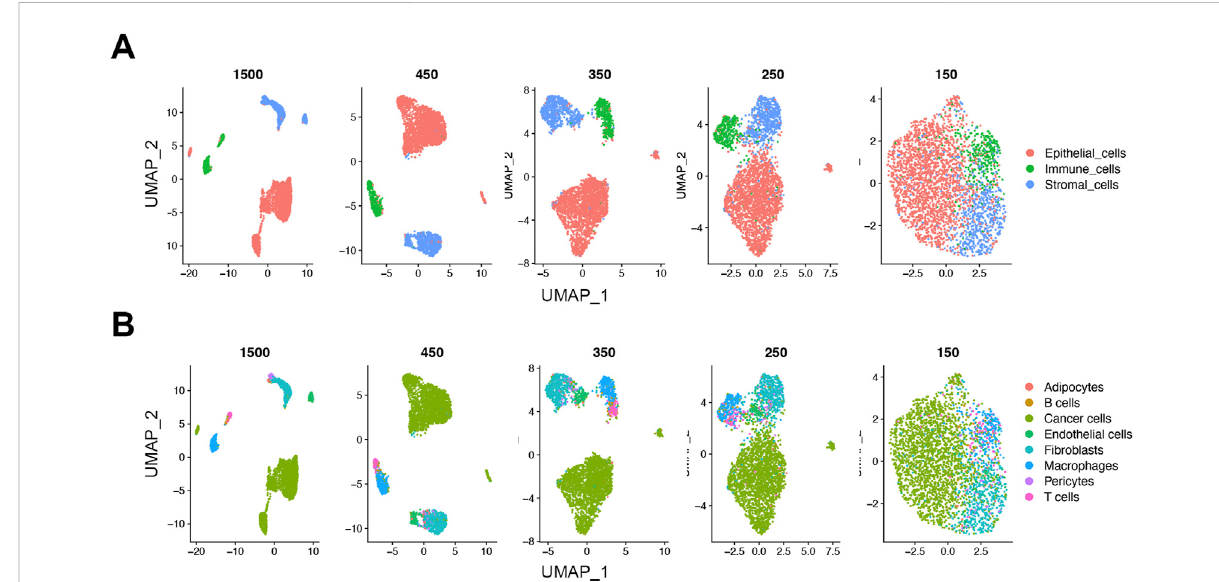
FIGURE 4 Loss of distinct cell clusters on UMAP below 450 UMIs in the FELINE dataset. Dimension reduction using Uniform Manifold Approximation and Projection (UMAP) shows that as count thresholds fall below 450 reads, a gradual loss of the distinct cell clusters is observed on lineage (A) , and cell type levels (B) ( n =